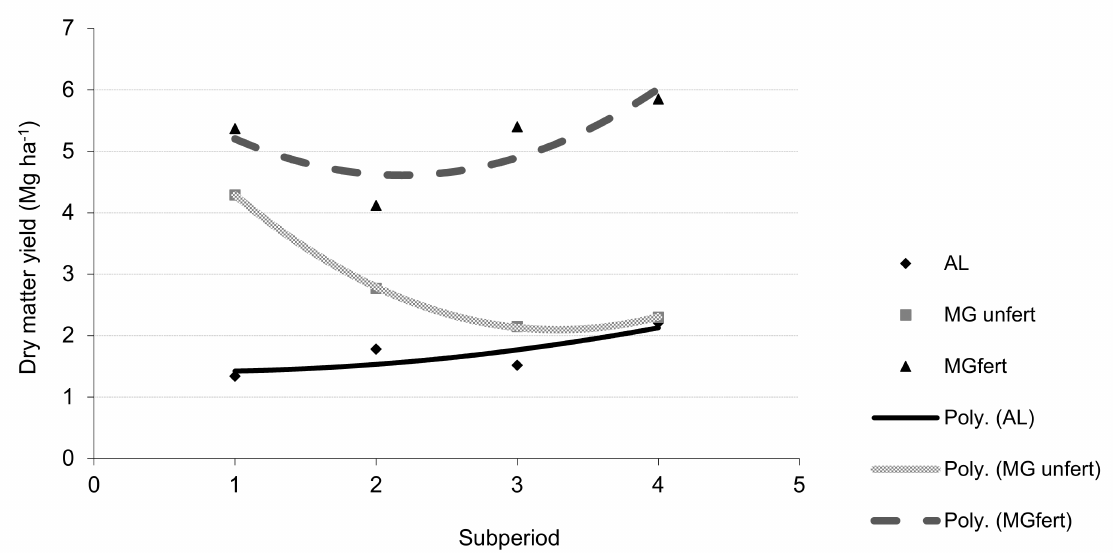
Figure 4. Trends in biomass DM yield (Mg ha − 1 ) of different grassland land uses in 1996–2019 (subperiod: 1—1996–2000; 2—2001–2005; 3—2008–2012; 4—2013–2019). Note. Abbreviations: AL, abandoned land; MG unfert –managed unfertilized grassland; MG fert , managed fertilized grassland. AL and MG unfert subplots were unfertilized, MG fert subplot was